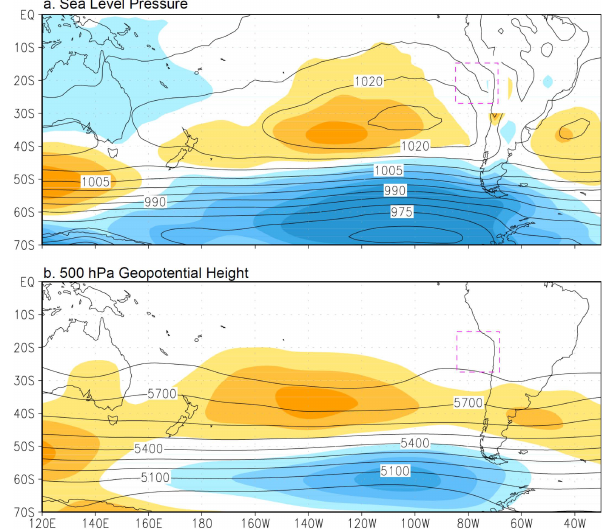
Fig. 1. NCEP-NCAR reanalysis of (a) mean sea level pressure (hPa, contours) and (b) mean 500-hPa geopotential height (m) from 15 October–29 November. Warm (cold) colors indicate positive (nega- tive) departures from long-term mean ( ± 3hPa for SLP and ± 50m for Z500). Dashed box indicates VOCALS